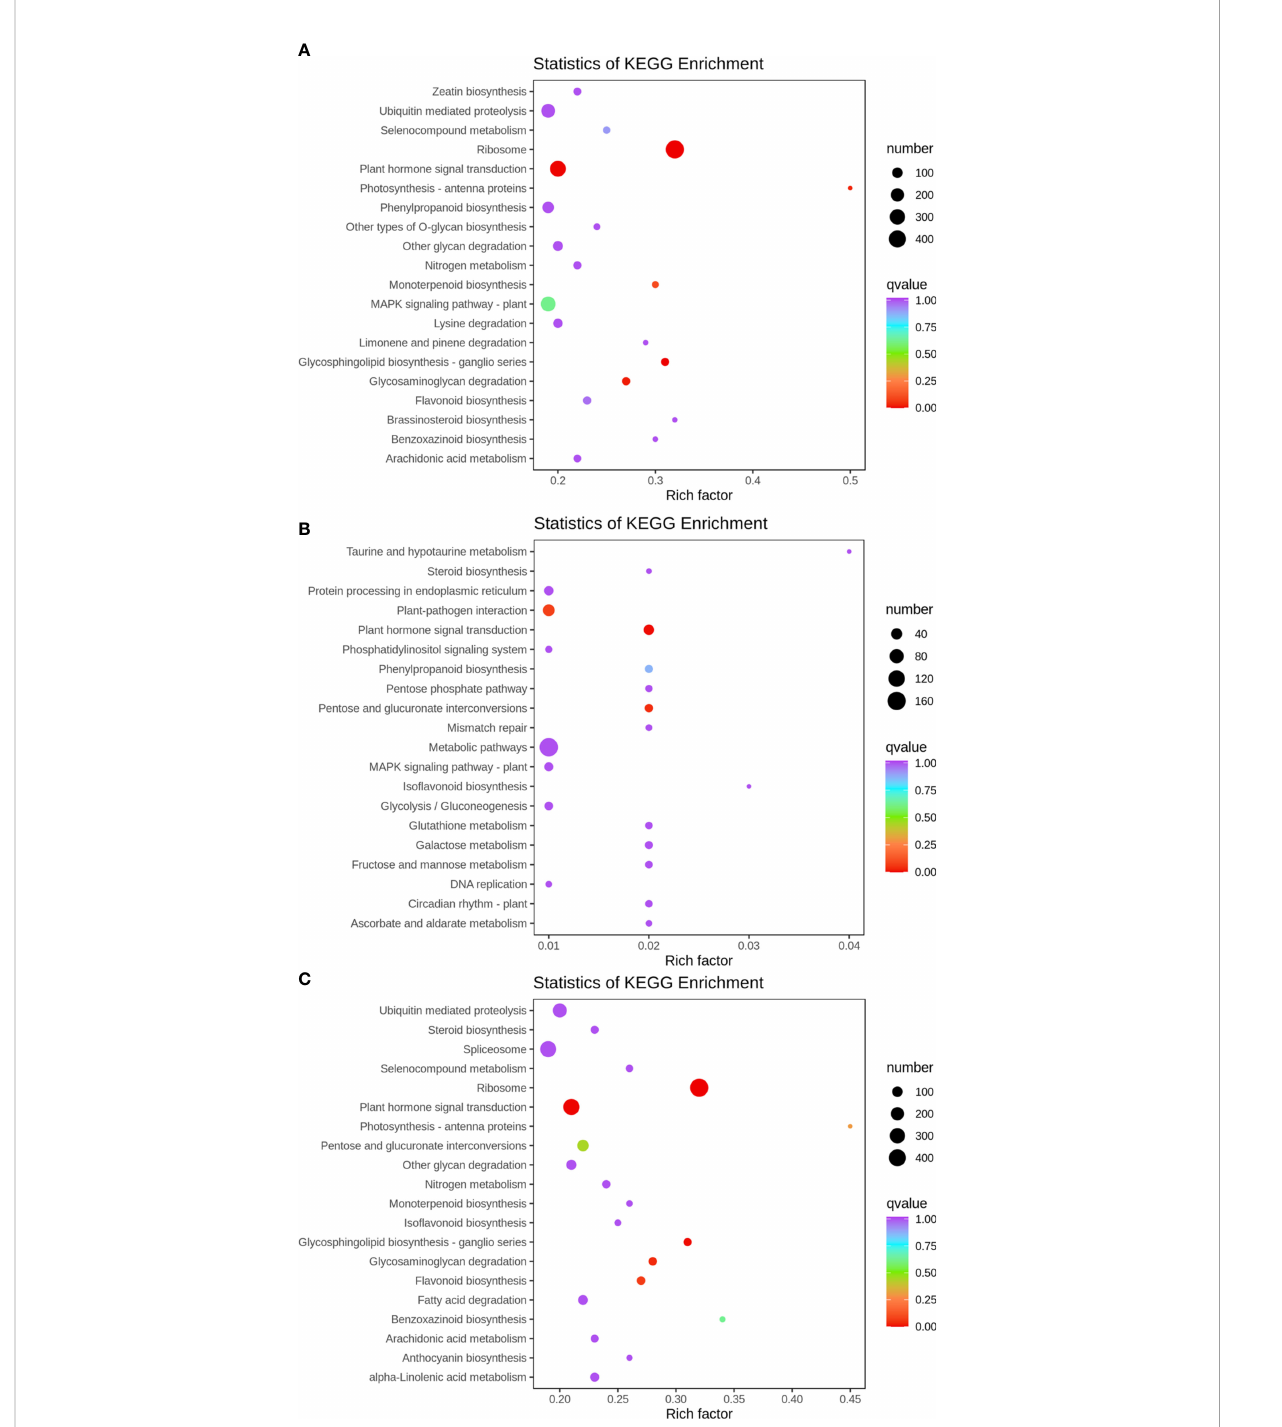
FIGURE 5 KEGG enrichment bubble plot. Differentially expressed genes generated by a comparison of (A) 35 d vs. 63 d, (B) 63 d vs. 69 d, (C) 35 d vs. 69 d. Rich factor represents the ratio of the number of differentially expressed genes enriched by the pathway to the number of annotated genes. The color bar represents the signi fi cance test p value adjusted for multiple hypothesis testing. The number represents the number of differentially expressed genes enriched in the